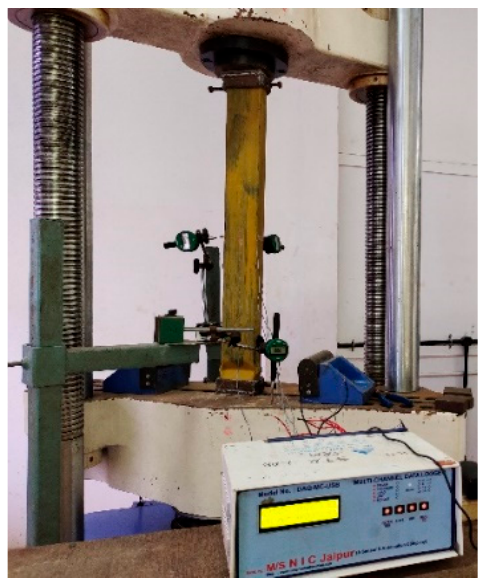
Figure 5. Test setup of hollow steel tubular column.